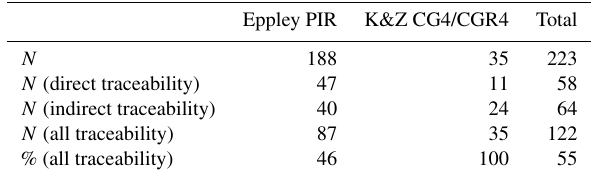
Table 3. The number of pyrgeometers which have submitted long- wave irradiance time series in the past to the BSRN archive are shown, as well as the number which have a direct or indirect trace- ability to the